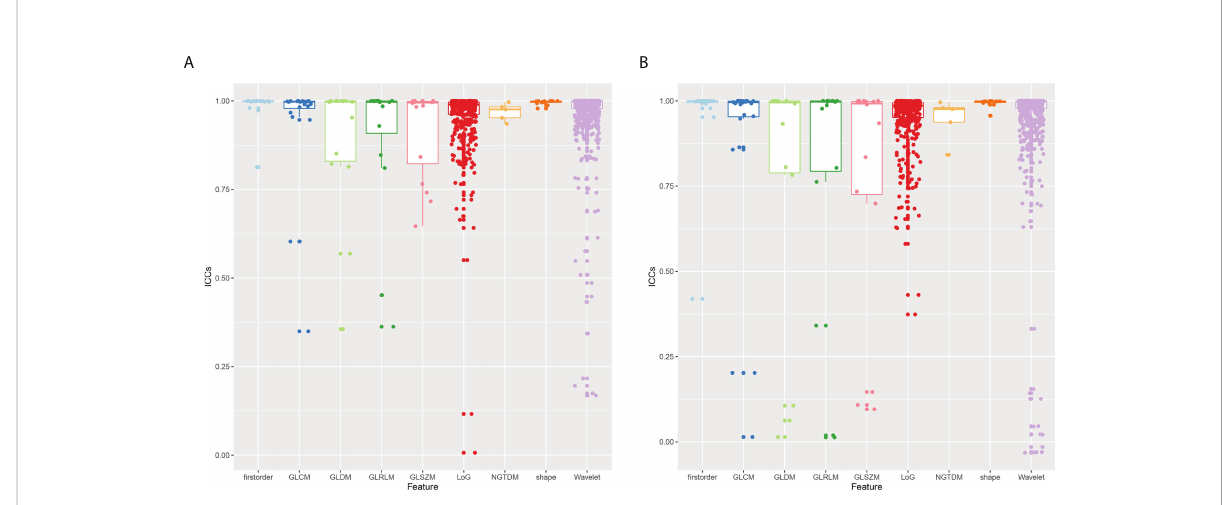
FIGURE 2 Boxplot of ICCs of radiomic features extracted from nine feature groups. (A) Intra-observer ICCs. (B) Inter-observer ICCs. ICCs, intra-class correlation coef fi